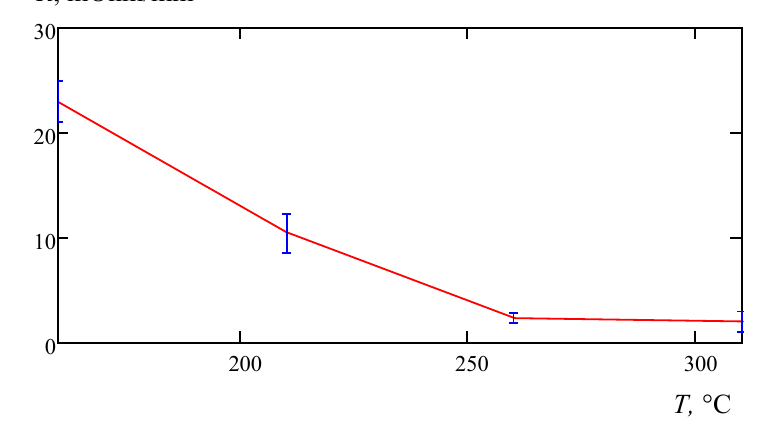
Fig. 9. Dependence of surface electrical resistance on the annealing temperature of film-line